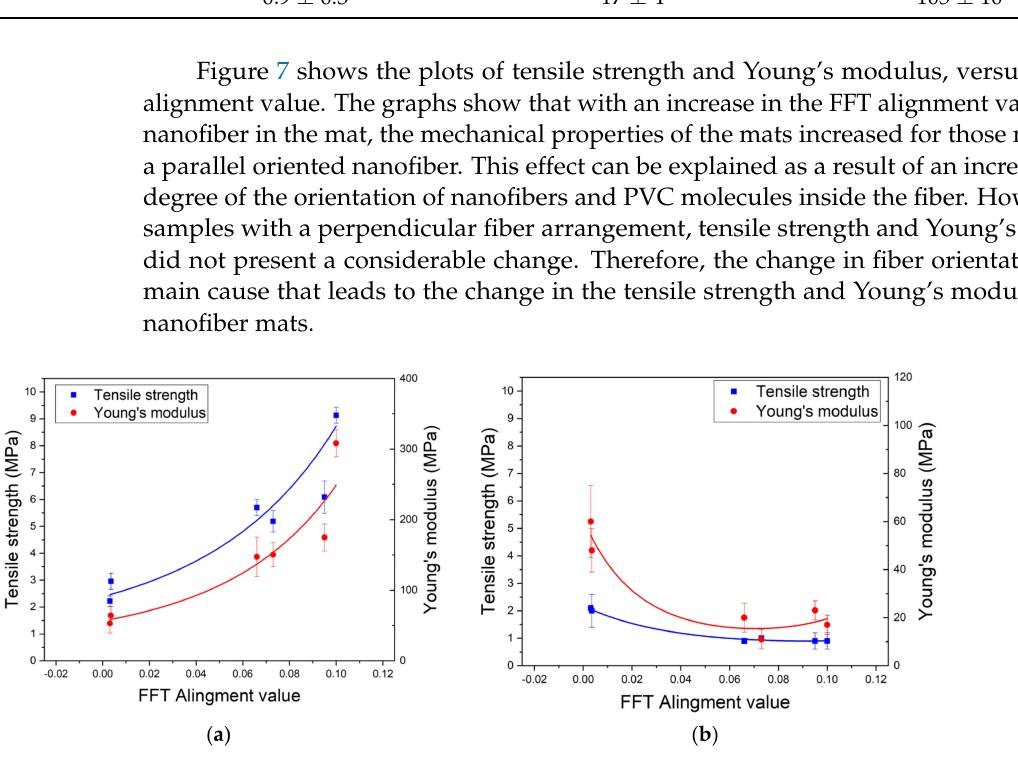
Tensile Strength, σ at break (MPa)